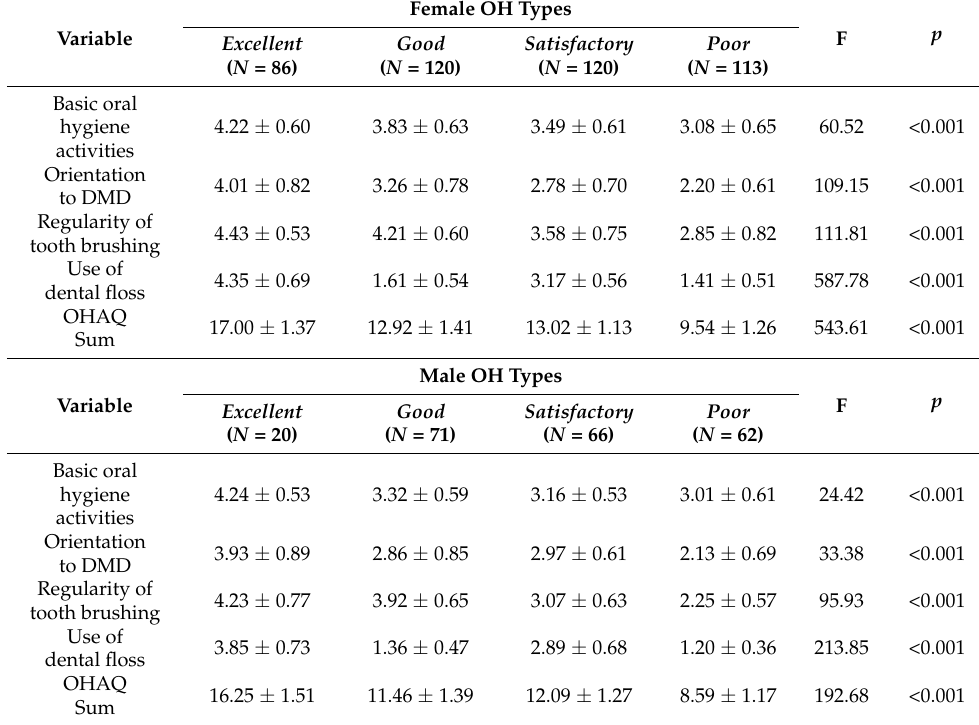
Table 5. OH types for female and male